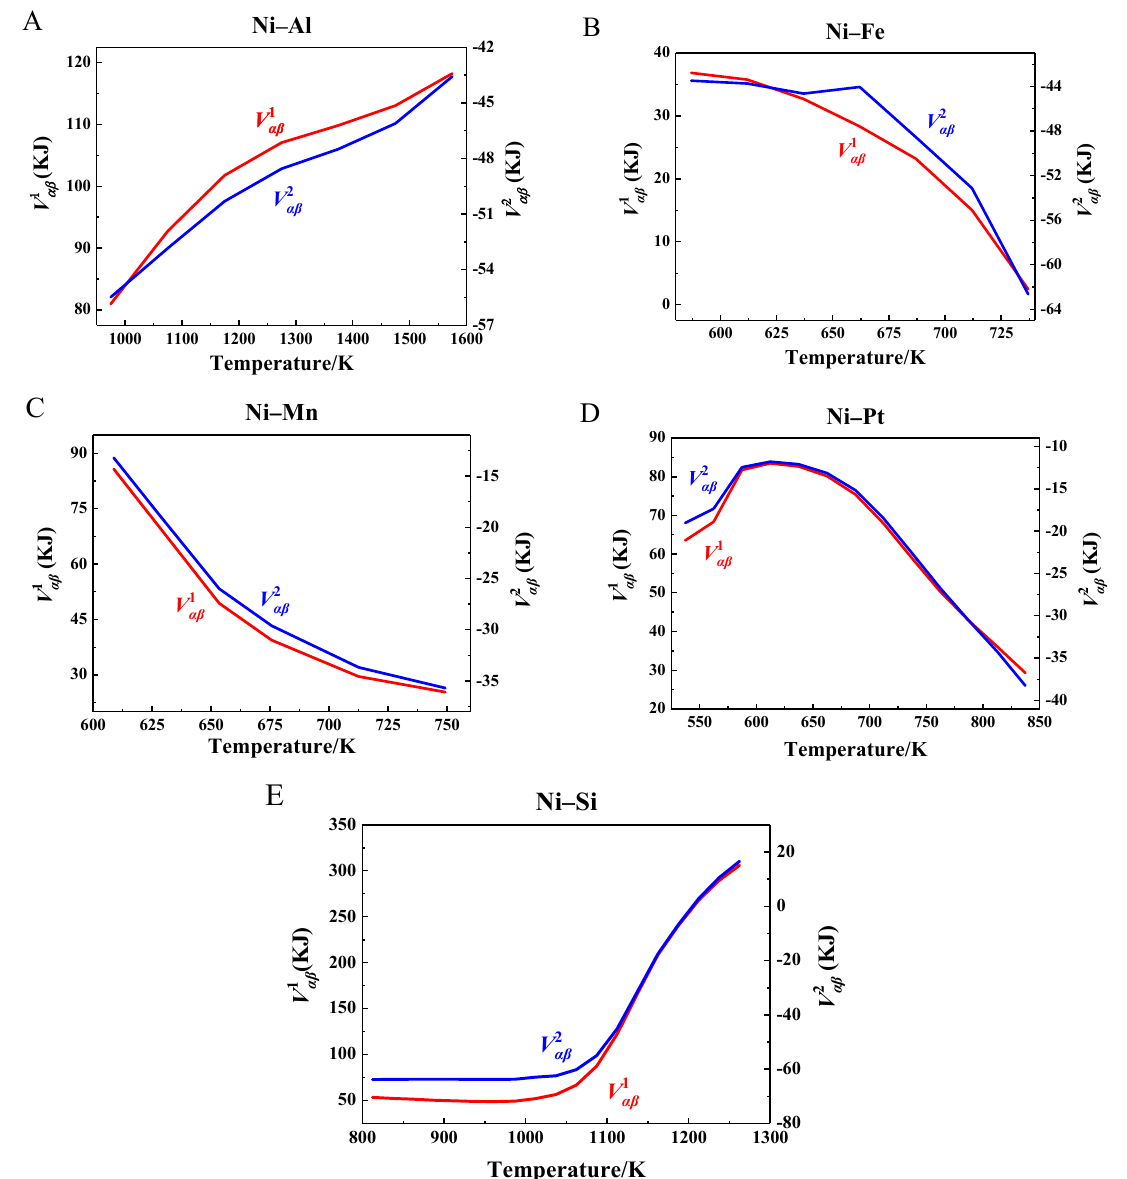
Figure 2. The 1st and 2nd nearest-neighbor interaction energies ( 𝑉 (cid:3080)(cid:3081)(cid:2869) and 𝑉 (cid:3080)(cid:3081)(cid:2870) ) for: ( A ) Ni–Al; ( B )